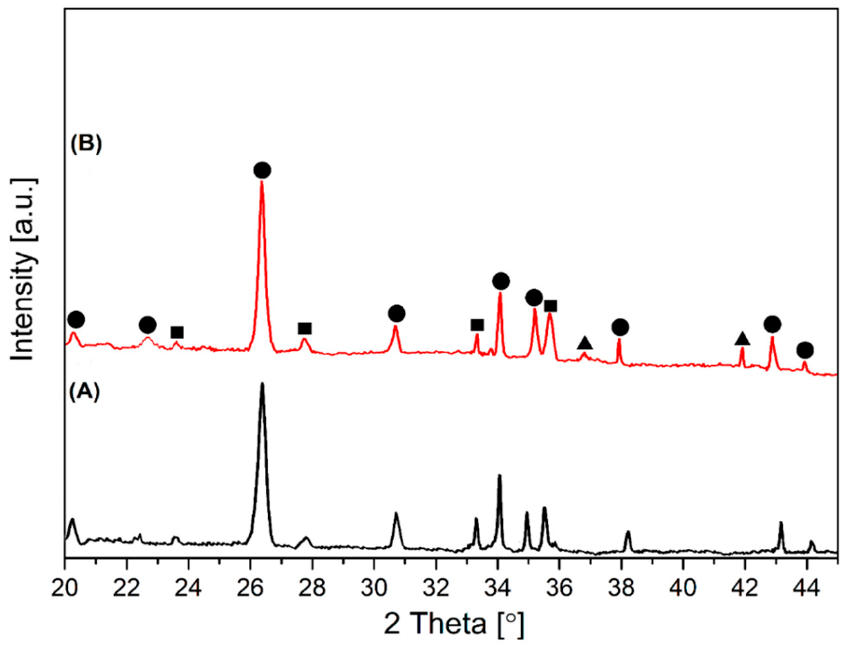
Figure 2. XRD patterns of ( A ) TC3030 and ( B ) α - β 20T ceramic nanocomposites (labelling “ ● ”, “ ■ ”, and “ ▲ ” denote α -SiAlON, β -SiAlON, and TiN, respectively). The investigation of microstructure by analyzing of SEM images showed bright and gray phases corresponding to TiN particles and α - β SiAlON ceramic, respectively (Figure 3A). Figure 3B exhibits energy-dispersive X-ray spectroscopy (EDS) maps of polished surface of sintered α - β 20T specimen, which confirms the uniform distribution of TiN particles. It is also important to note that the mean particle size of ceramic matrix with and without TiN was similar, around 2.1 µ m (Figure 4). Consequently, the presence of TiN did not affect the grain growth of SiAlON